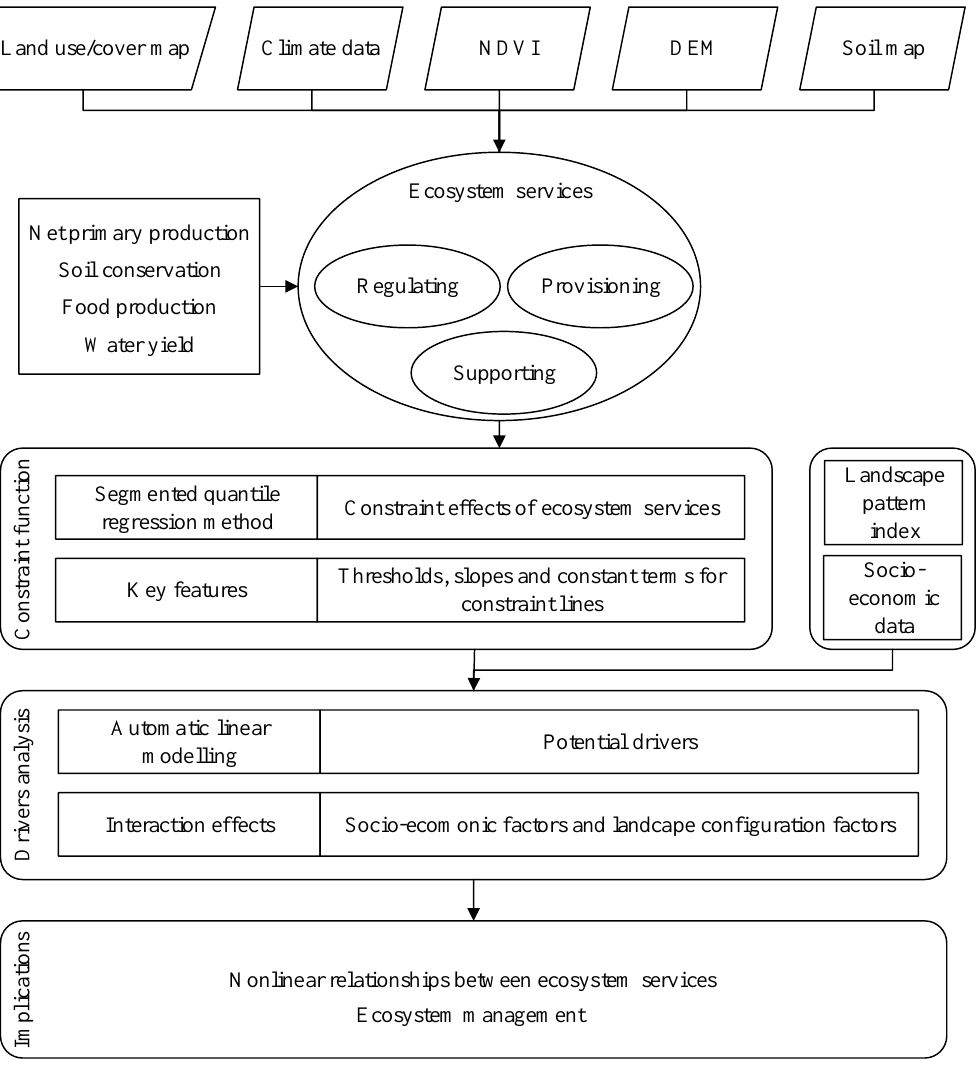
Figure 3. Methodological framework.